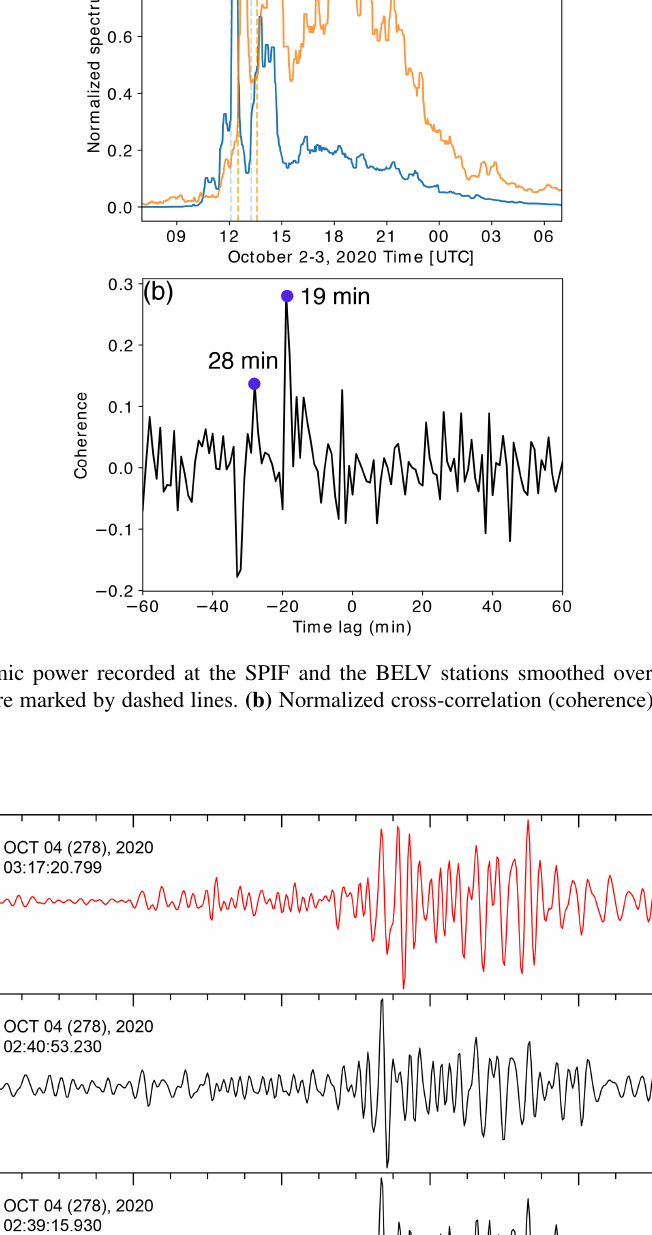
Nat. Hazards Earth Syst. Sci., 22, 1541–1558, 2022